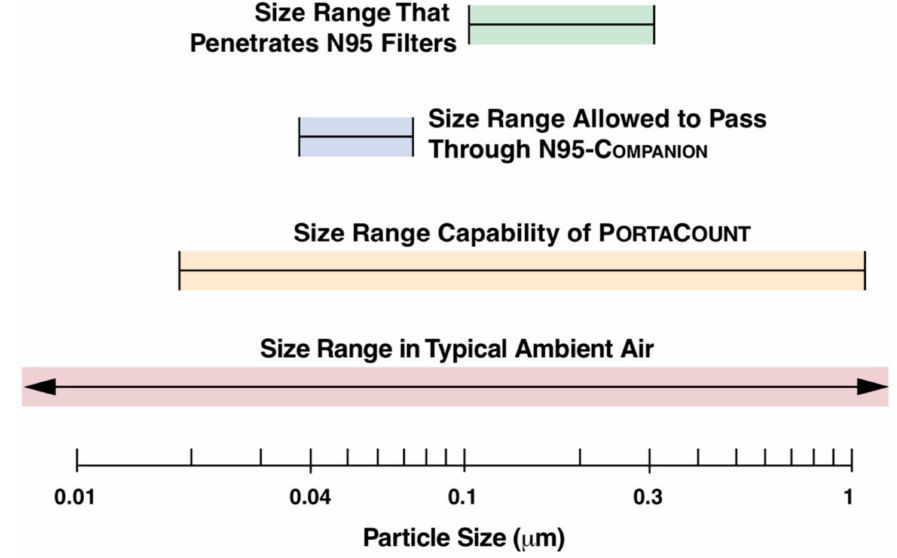
Figure 4. Principle of N95 Companion Protocol (modified from